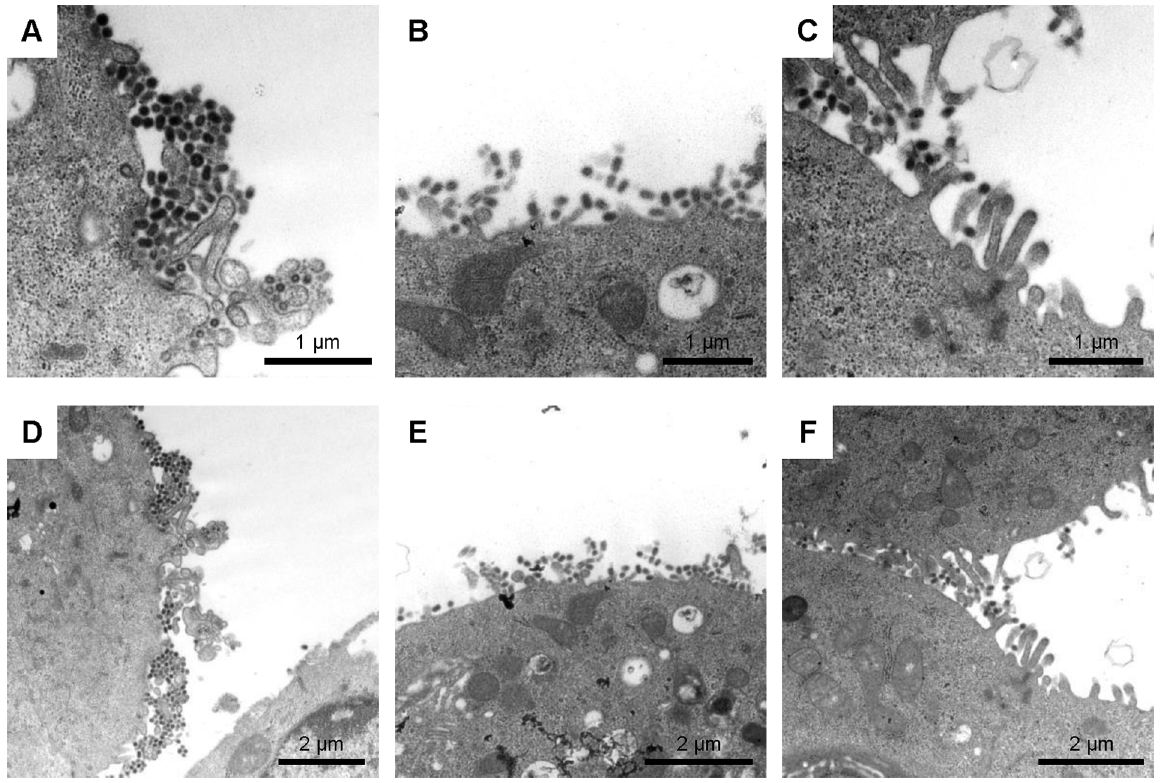
Figure 5. Viral particles deposited on the surface of infected cells cultured with S139/1 IgA. MDCK cells were infected with Aichi/H3 and incubated for 8 hours in the presence of S139/1 IgA (A and D), IgG (B and E), or in the absence of antibodies (C and F). TEM images of the cell surface are shown at high (A to C) and low (D to F) magnifications. Scale bars represent 1 m m (A to C) and 2 m m (D to F).